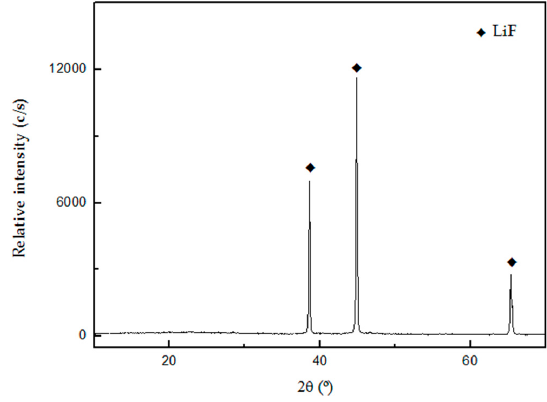
Figure 9. Diffractogram of the precipitated LiF.